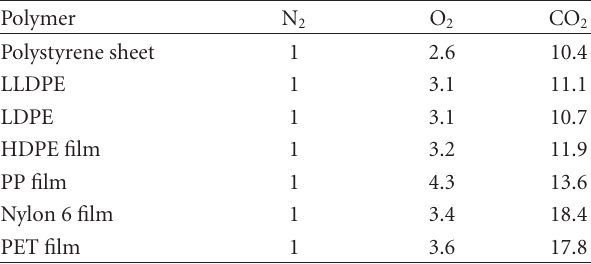
Table 2: Relative value of permeabilities for the most commercial polymer (no-dimensional